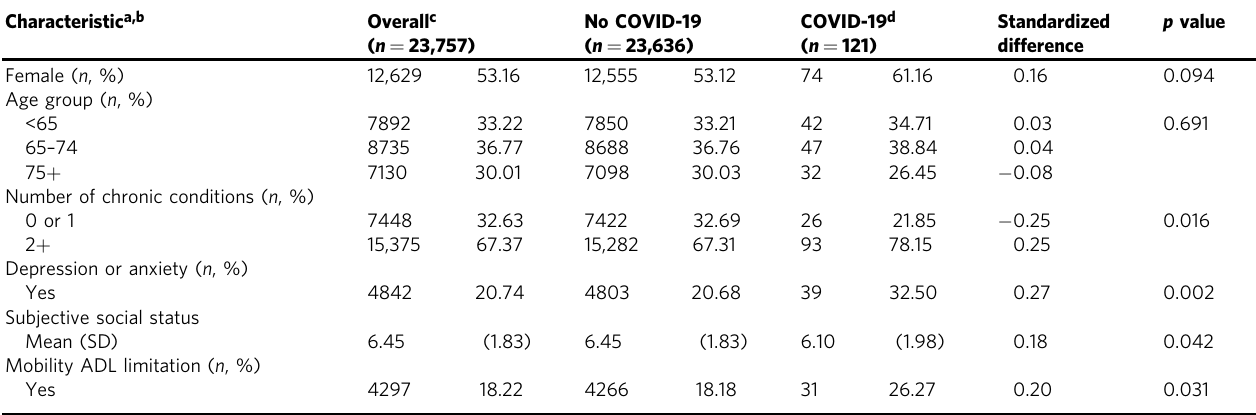
Table 1 Demographic and pre-pandemic physical, psychological and social health and function data for 23,757 participants of the CLSA COVID-19 Exit interview, overall and by COVID-19 status. Characteristic a,b Overall c Standardized